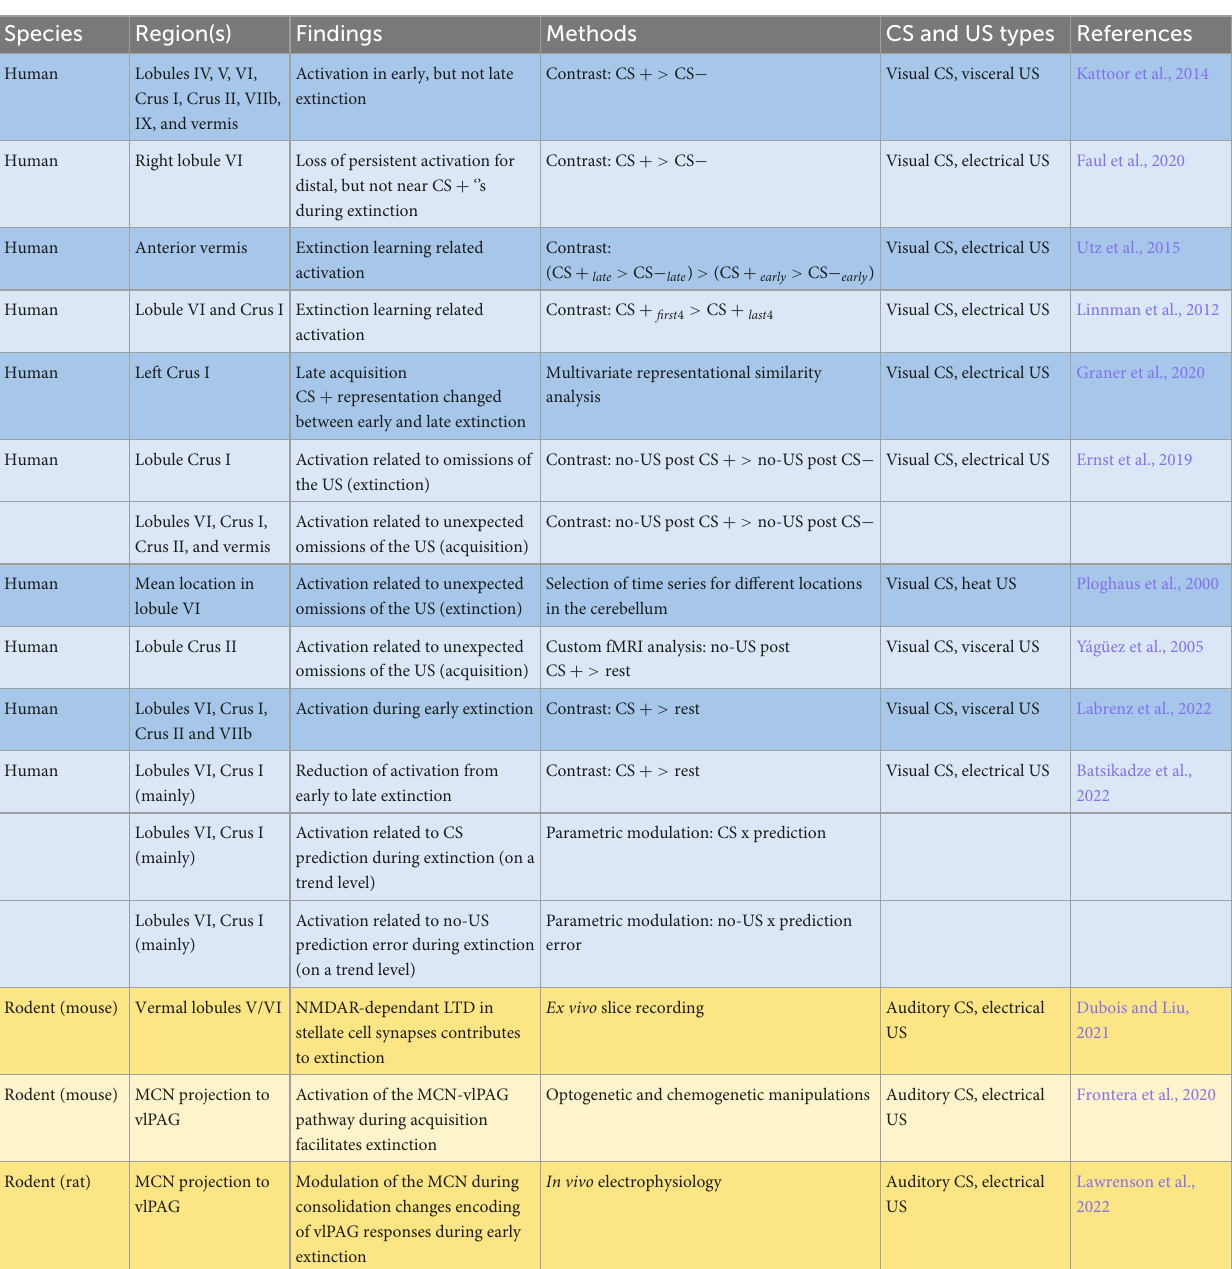
TABLE 1 Studies which support a role of the cerebellum in fear